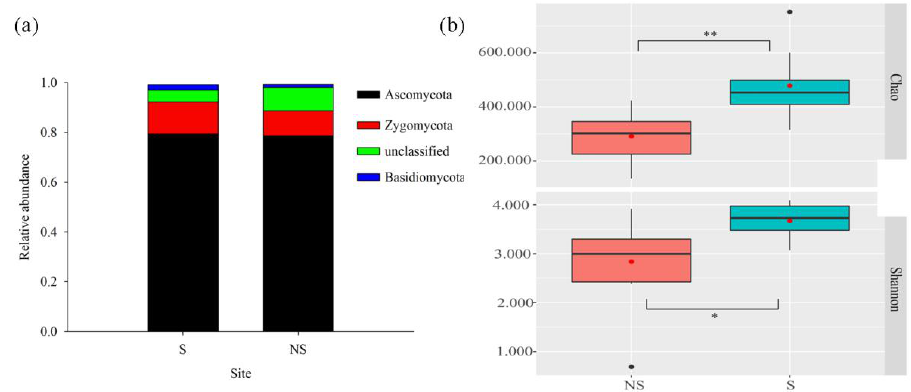
Figure 6. Relative abundances (average values >= 0.01) of dominant phylum composition ( a ) and alpha diversity ( b ) of the soil fungal community. * p < 0.05, and ** p < 0.01. Black dots indicate inter-group differences, and red dots indicate intra-group differences. Same as below.